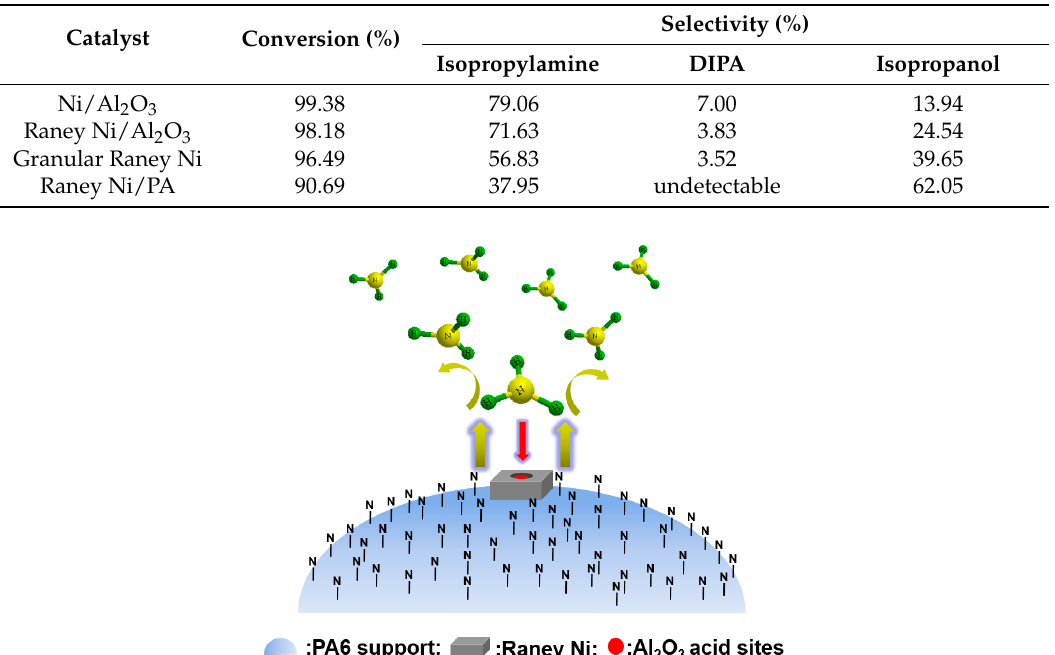
Figure 8. Schematic representation of prevention process of NH 3 from adsorption. Reproduced from [18] with permission from Jiang H., Sci. China Chem.; published by Springer, 2016.